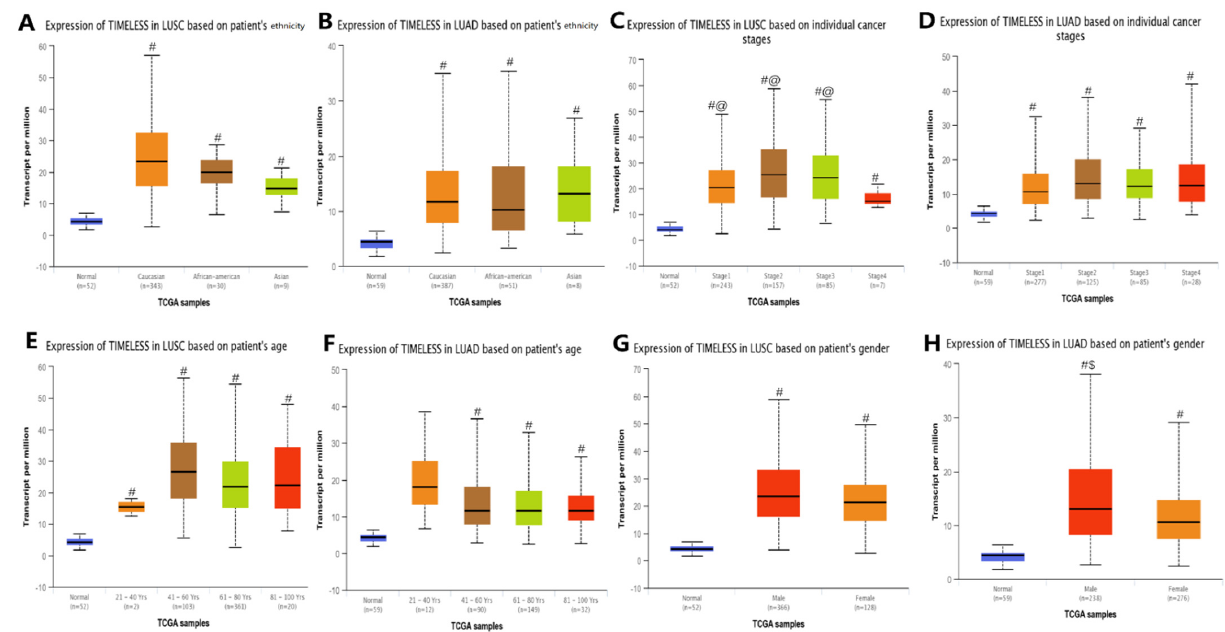
Figure 4. Association of Timeless gene expression with clinicopathological parameters of patients with lung cancer. ( A , C , E , G ) Timeless gene expression and clinicopathological parameters of patients with LUSC. ( B , D , F , H ) Timeless gene expression and clinicopathological parameters of patients with LUAD. # p < 0.05 vs. normal group; @ p < 0.05 vs. cancer stage 4; $ p < 0.05 vs. female group. TCGA, The Cancer Genome Atlas; LUSC, lung squamous cell carcinoma; LUAD, lung adenocarcinoma.